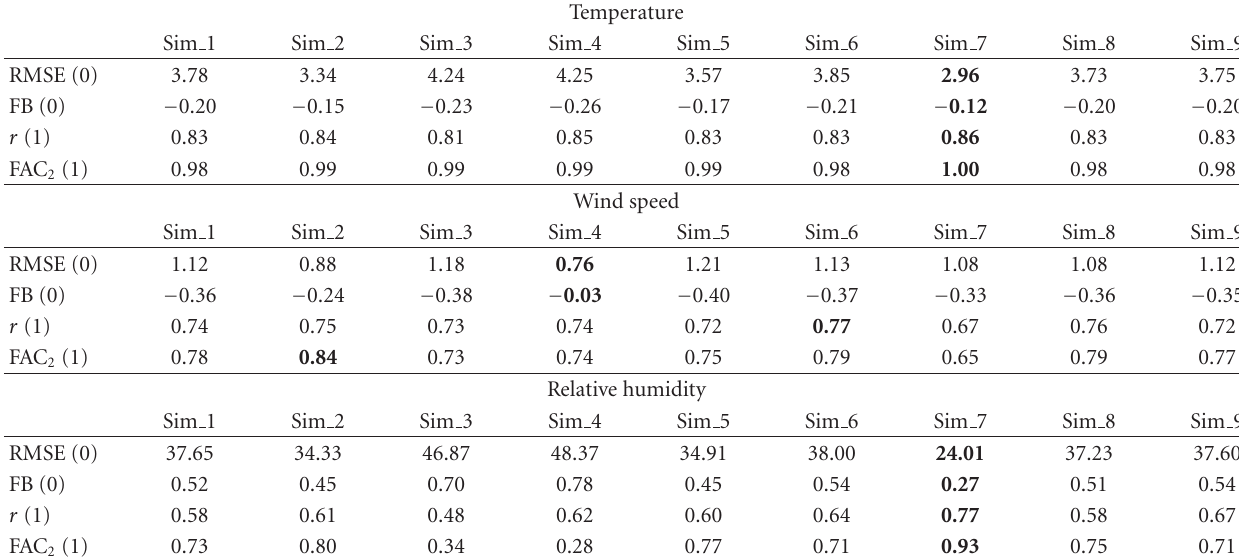
Table 3: Statistical evaluation of winter simulations, station 1.